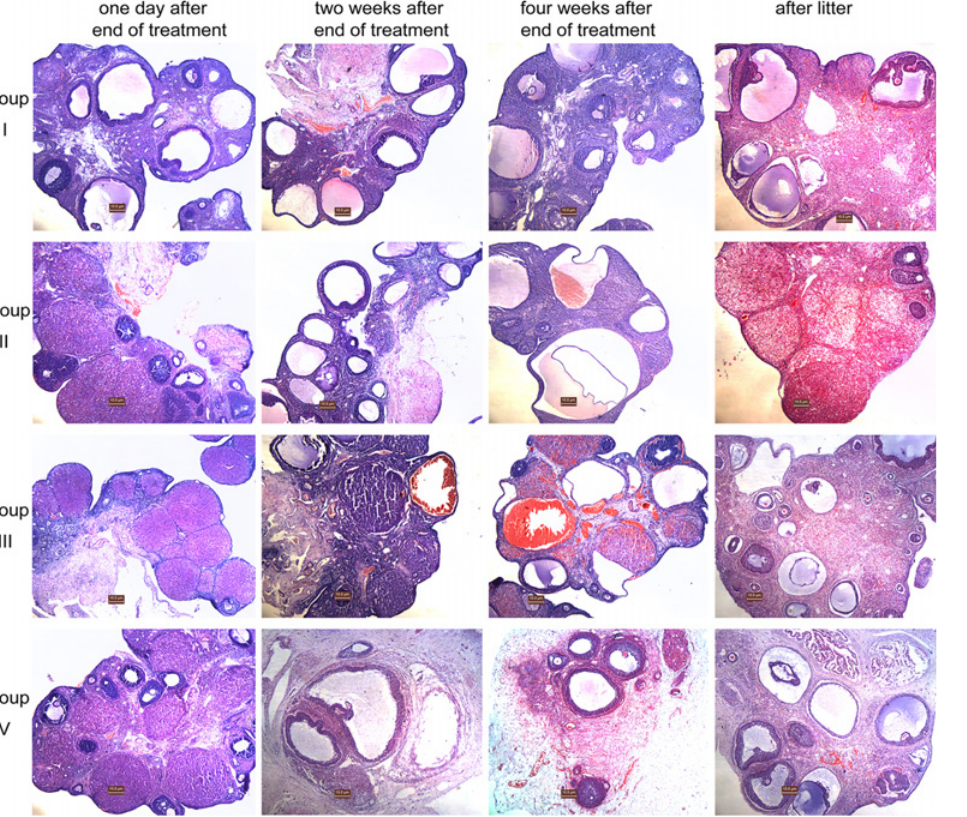
Fig 3. Histological examination of the ovaries at different time points. Morphological representation of the ovaries of different experimental groups at different time points stained by H&E. (original magnification ×50, Bar = 10 um).